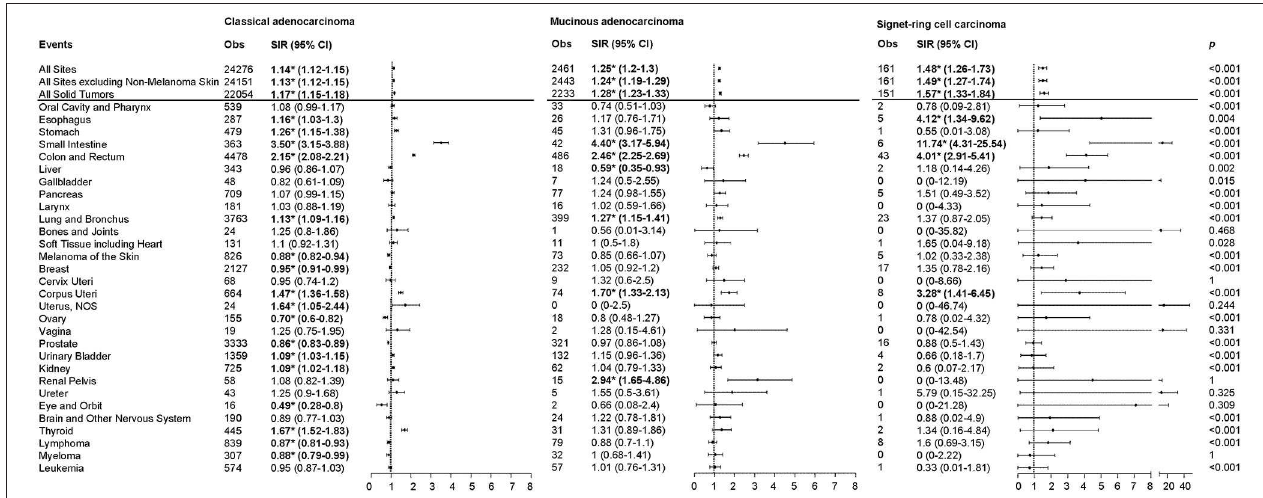
FIGURE 1 | SIRs for SPMs at various anatomical sites based on the histological subtypes of the first primary CRC. Obs, observed events; SIR, standard incidence ratio; CI, confidence interval. * P < 0.05 (compared with general population). P -values comparing SIR differences among colorectal cancer subtypes were calculated using Poisson